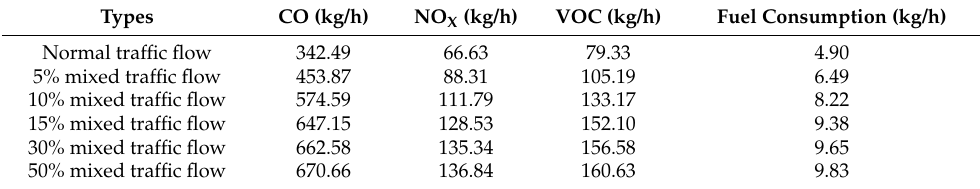
Table 4. Average emissions and fuel consumptions under different cruising